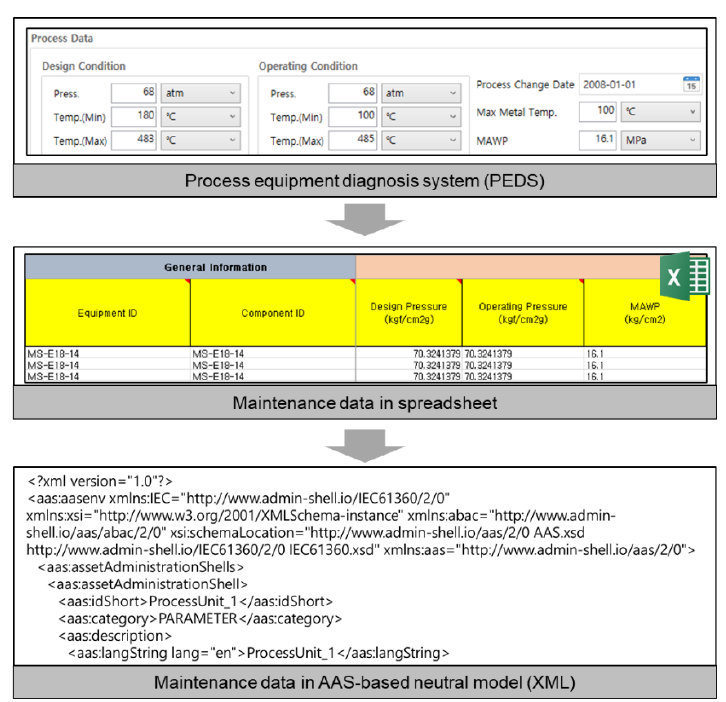
Figure 13. Maintenance data conversion to AAS-based neutral model data.